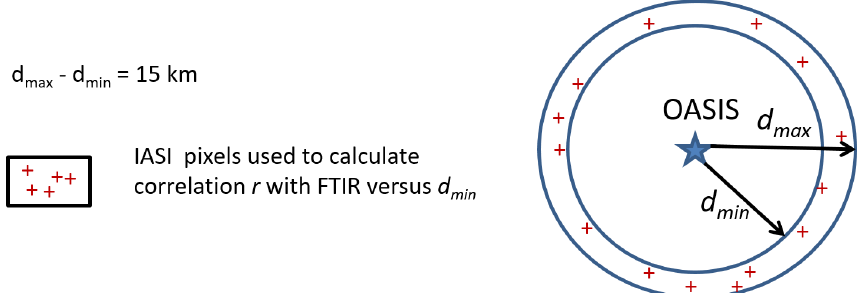
Figure 7. Description of the 15km rings centered on OASIS observatory that were used to select different IASI pixels for the correlation with FTIR data.